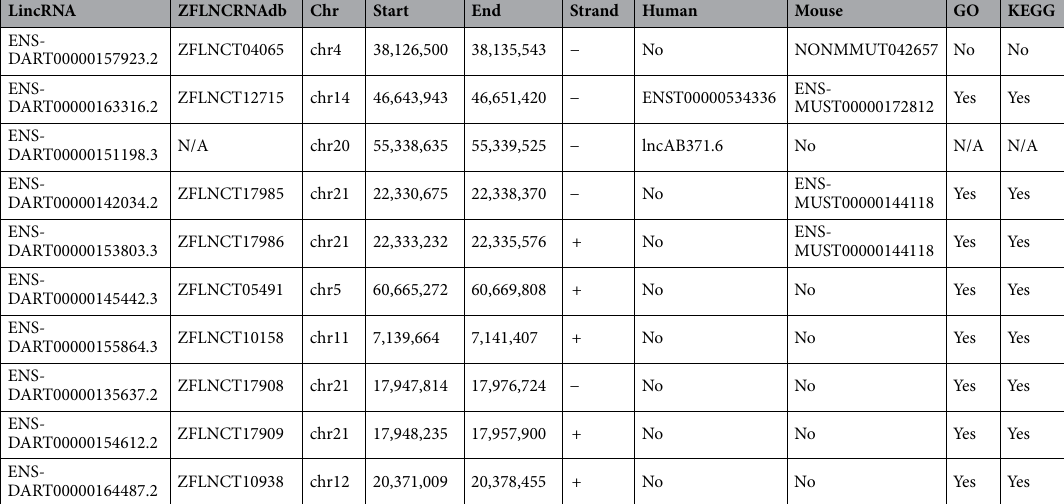
Table 7. List of differentially expressed lincRNAs in the generation F 1 from exposed (8.7 mGy/h γ-radiation) (F 1 -γ) parents with conserved orthologs in human and/or mouse and functional annotations. Transcript IDs obtained from Ensembl database (http://www.ensem bl.org) and ZFLNCRNA Database (http://www.zflnc .org)